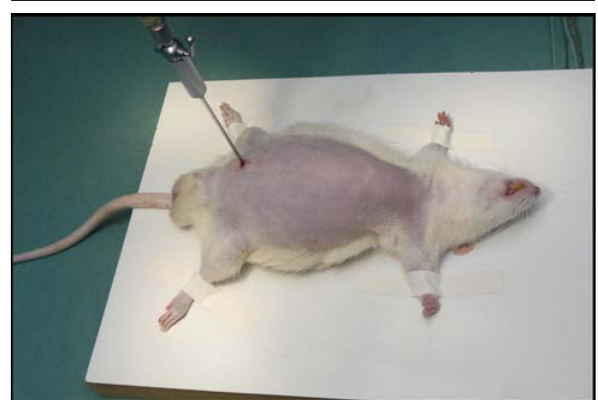
FIGURE 1 - Needle of Veress and pneumoperitonium installed